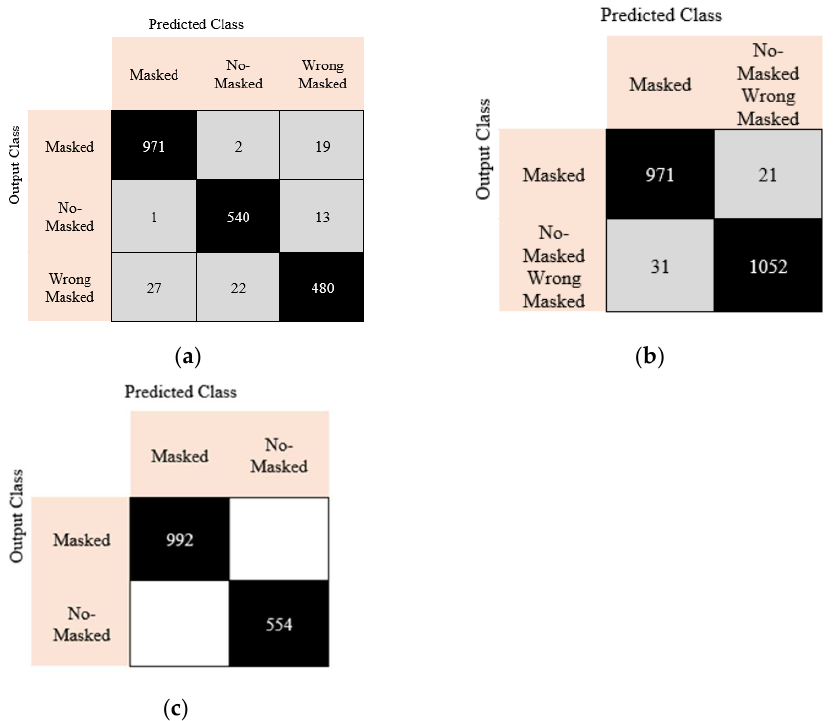
Figure 6. Confusion matrices resulting from training and testing the model with the three different cases: ( a ) Case 1, ( b ) Case 2, and ( c ) Case 3.